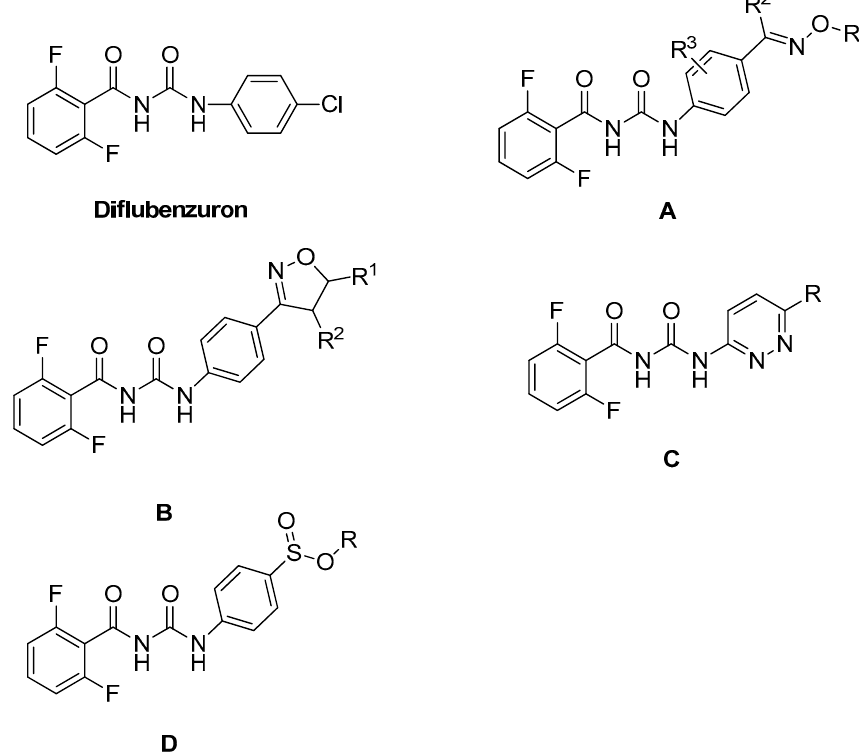
Figure 1. Chemical structures of benzoylurea compounds.